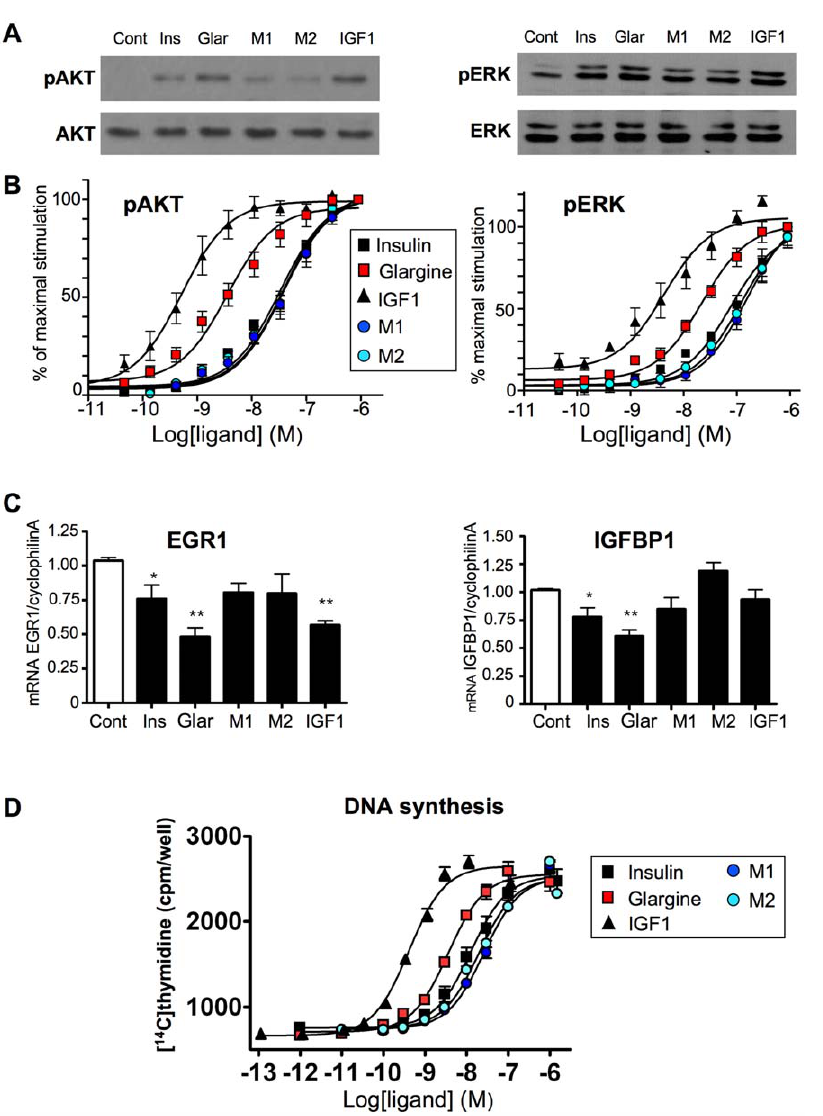
Figure 4. Downstream biological effects of insulin, glargine and its metabolites M1 and M2 in MCF-7 cells. (A) Effect of insulin, IGF1, glargine and its metabolites M1 and M2 on Akt and Erk1/2 phosphorylation in MCF-7 cells. MCF-7 cells were starved overnight and then incubated for 5 min in presence of 10 nM of insulin, glargine, M1, M2 or IGF1. Ligand-induced phosphorylation of Erk1/2 and Akt was evaluated by western blotting. (B) Dose-dependent effect of insulin, IGF1, glargine and its metabolites M1 and M2 on Akt and Erk1/2 phosphorylation in MCF-7 cells. Cells were stimulated for 20 min and ligand-induced phosphorylation of Akt and Erk1/2 was evaluated by in-cell western. Results correspond to mean 6 SEM of 4 to 6 independent experiments. (C) MCF-7 cells were incubated for 18 h in serum free medium in the presence or absence of 10 nM of insulin, glargine, M1, M2 or IGF1. mRNA expression level was measured by qRTPCR. Results are normalized to the expression of cyclophilin A mRNA and correspond to the mean 6 SEM of 4 to 8 independent experiments (*, **, p , 0.05 or p , 0.01 respectively, when compared to the control condition). (D) Subconfluent MCF-7 cells cultured in Cytostar-T scintillation microplates were starved for 4 h and then incubated for 19 h with increasing concentrations of IGF-1, insulin or analogues in serum free medium. [ 14 C]thymidine was added for an additional 6 h and the radioactivity measured in a Wallac 1450 Micro Beta Trilux Scintillation counter. Data are means 6 SEM of at least 6 independent experiments. EC50 for insulin, IGF1, glargine and its metabolites on Akt and Erk1/2 phosphorylation and on thymidine incroporation are given in Table